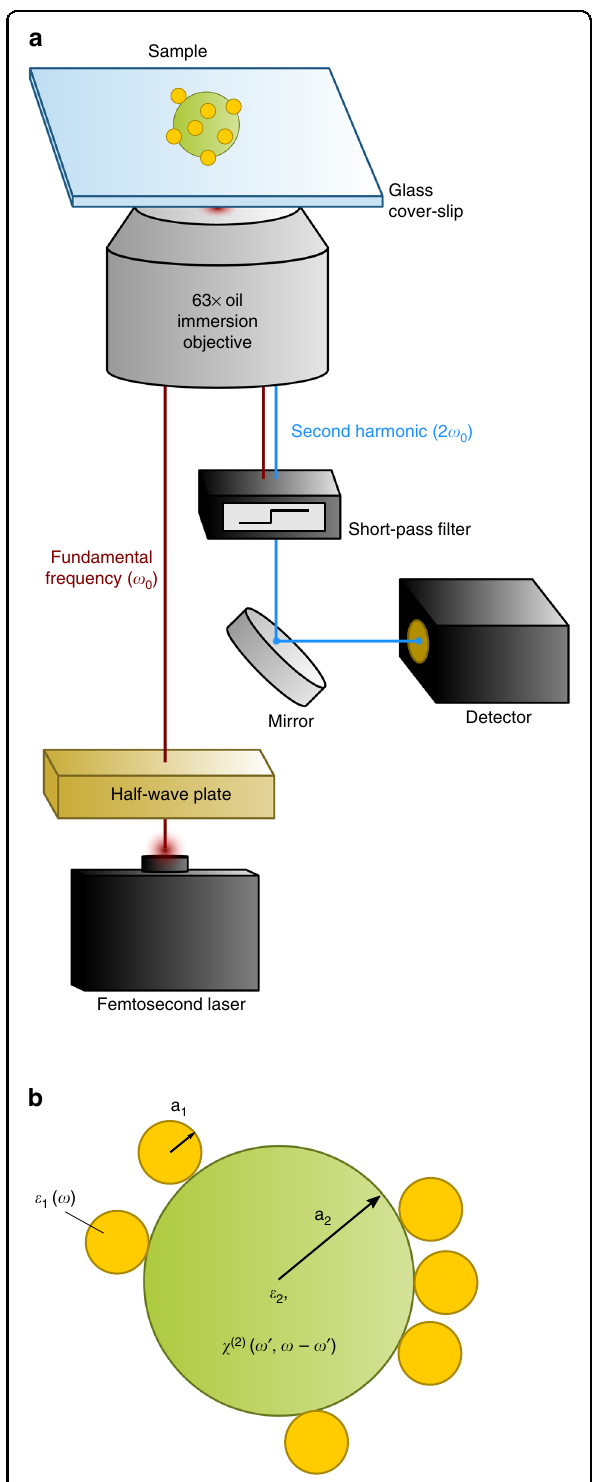
Fig. 2 Experimental geometry. a Schematic of the microscope con fi guration used to characterize the second harmonic generation (SHG) response of single particles. This microscope was operated in a re fl ection mode setup and was equipped with a femtosecond laser, half-wave plate, and objective lenses of different magni fi cations including a 63× oil immersion lens. b Sketch of the sample geometry of the hybrid Au – LiNbO 3